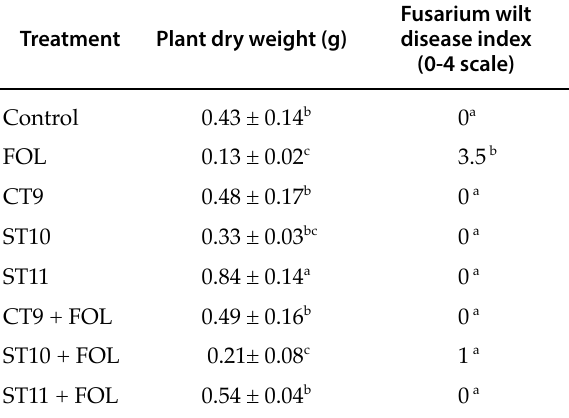
Table 6. Mean plant dry weights and Fusarium wilt sever- ity indices for tomato plants treated with the Trichoderma spp. strains CT9, ST10 and ST11, in a 30 d pot